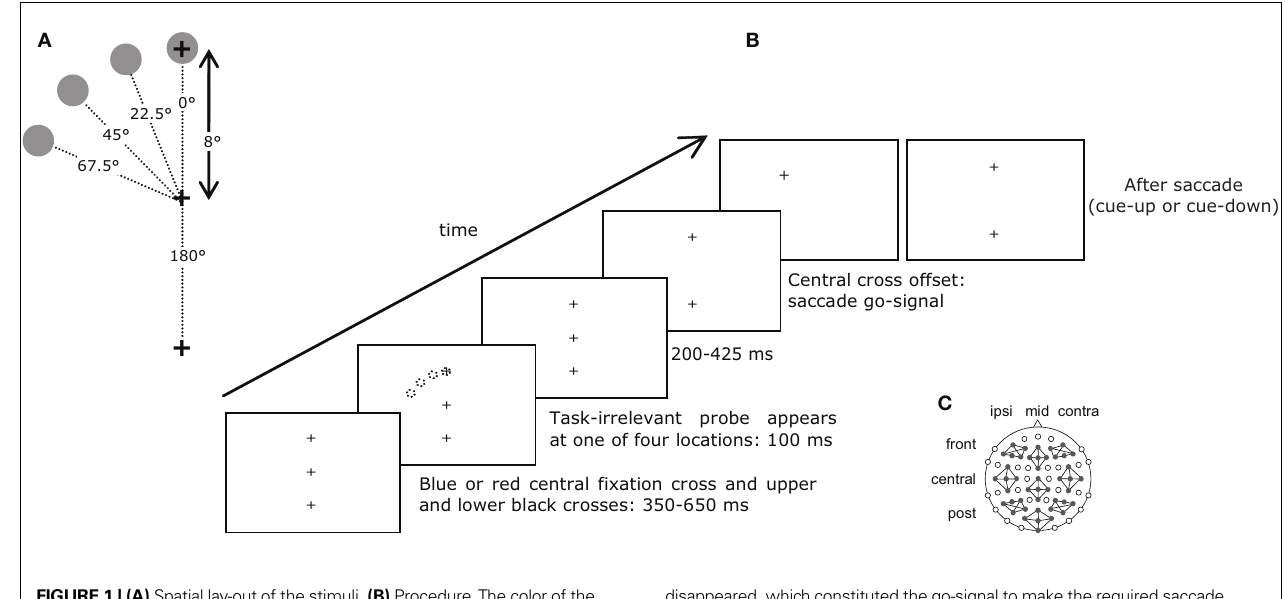
FIGURE 1 | (A) Spatial lay-out of the stimuli. (B) Procedure. The color of the central cross cued the saccade to be made: to the upper or lower target. After 350–650 ms, a probe appeared at one of four equidistant locations in the upper hemisphere for 100 ms. After another 200–450 ms, the central cross